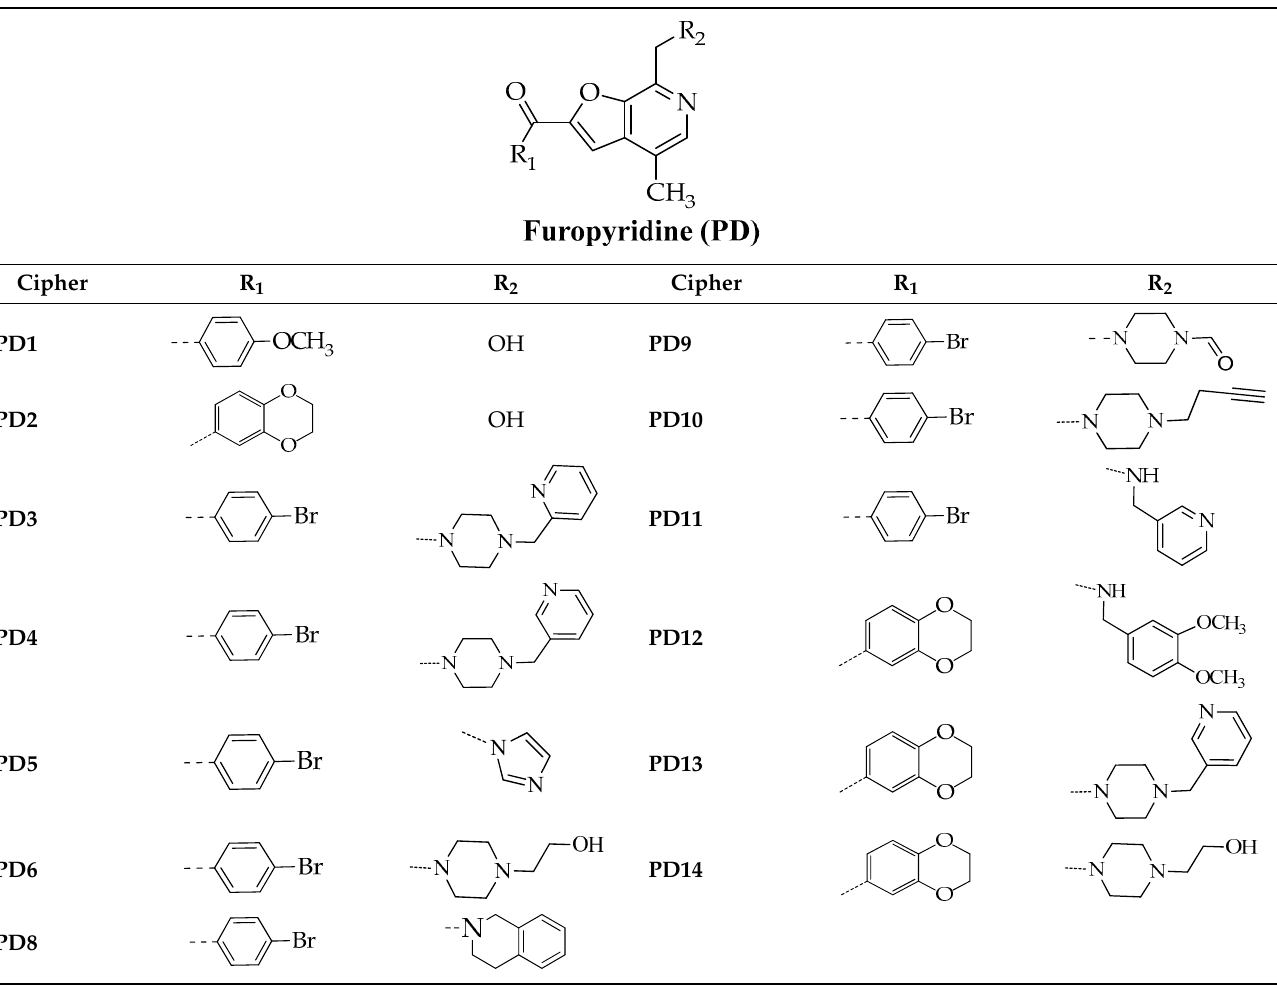
Table 1. Chemical structure of furopyridine; PD and its derivatives.